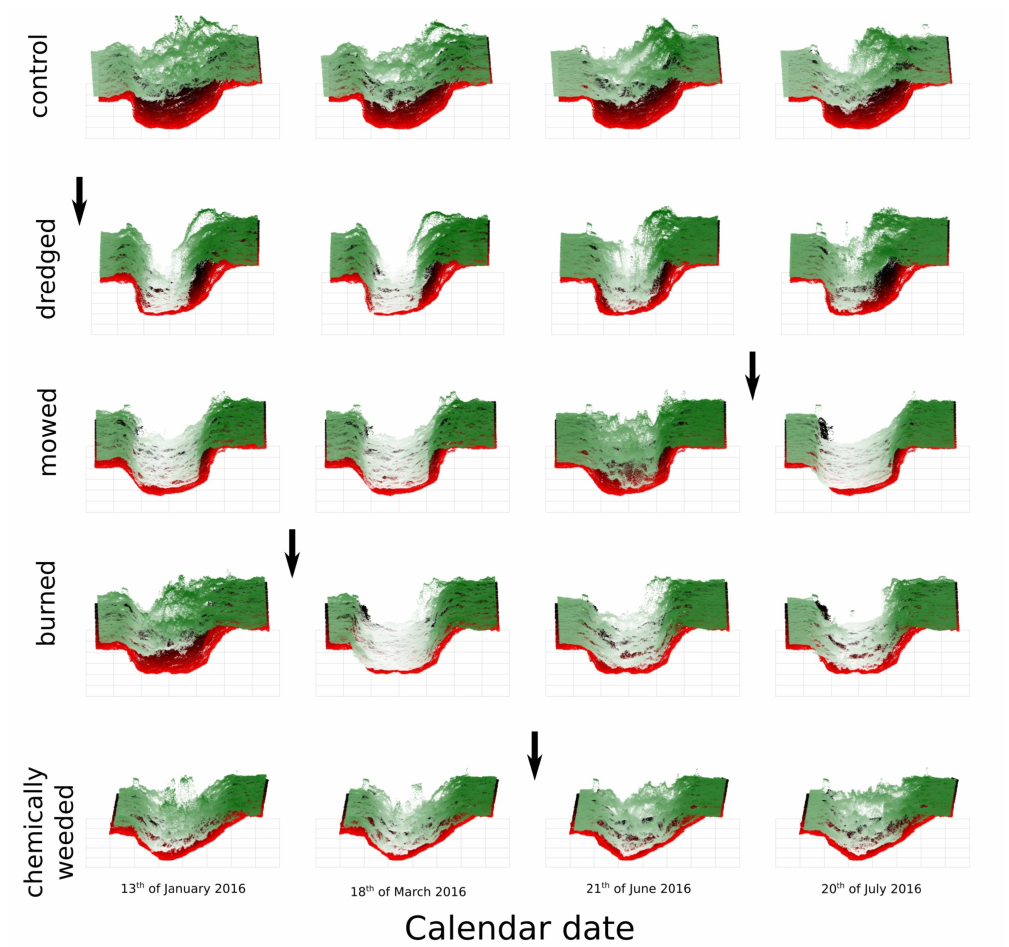
Figure 6. Time series of the point clouds showing the DTM (in black and red) and the DSM (in white and green) at a 1-cm resolution for four representative surveys in 2016 across different treatments presented in rows from top to bottom: control, dredged, mowed, burned, and chemically weeded. Black arrows indicate the timing of the